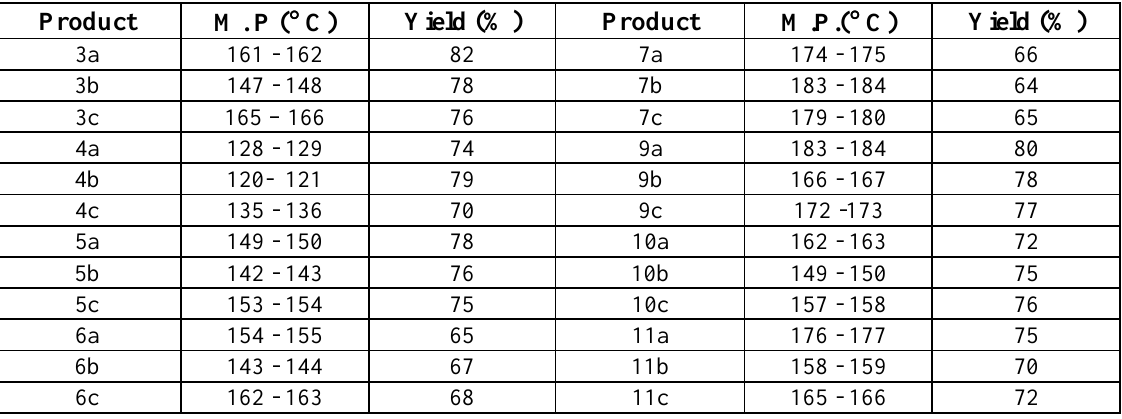
Table 1. Physical data of compounds 3-7 and